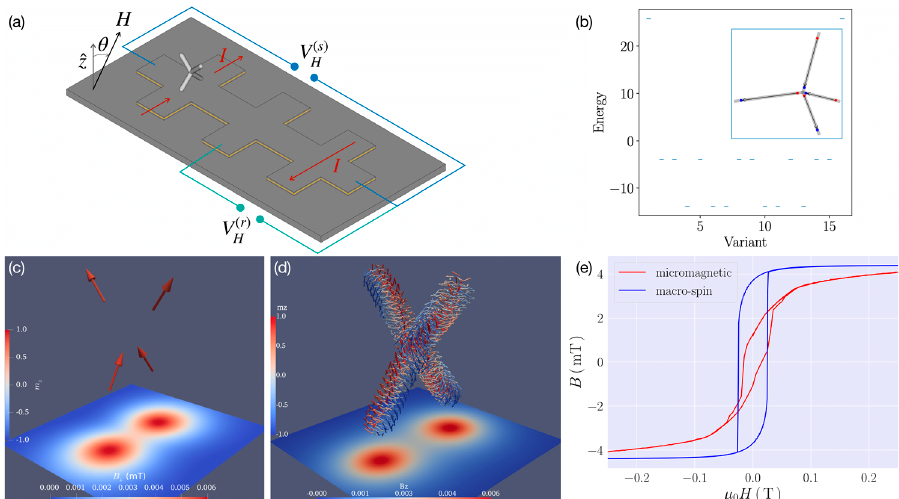
Figure 7. ( a ) Schematic of typical gradiometry setup for micro-Hall magnetometry with a tetrapod 3D ferromagnetic structure fabricated by FEBID; see [85] for details. From the measured Hall voltages V H(s) and V H(r) , the magnetic stray field generated by the tetrapod can be deduced. ( b ) Energy diagram of a tetrapod structure assuming uniformly magnetized arms within the dumbbell approximation. The sixfold degenerate ground state refers to the “two in – two out” ice rule for tetrahedral spin ice [86]. Configuration #4 shown in the inset depicts one of the possible ground states. ( c ) Macrospin model for the tetrapod with uniaxial anisotropy along the arm directions in zero field, where a “two in–two out” state is realized. ( d ) Result of zero-field micromagnetic simulation of tetrapod structure using mumax 3 [85] with material parameters of Co 3 Fe; see [85] for details. The colour code on the plane of the 2DEG represents the z-component of the magnetic stray field generated by the tetrapod. ( e ) Comparison of results of stray field calculations for Co 3 Fe tetrapod with field perpendicular to the 2DEG. Micromagnetic (red) and macro-spin (blue) simulation show roughly corresponding coercive fields but clear differences in details of the stray field hysteresis. Suitable parameter selection for the macro-spin simulation can reduce these differences to some degree; see [28] for details.